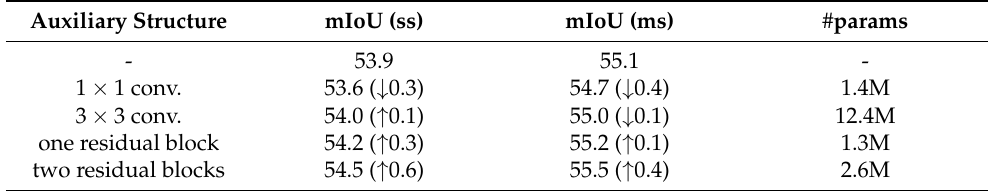
Table 2. Performance comparison of various auxiliary CNNs using the ADE20K validation set. ss: single-scale. ms: multi-scale.